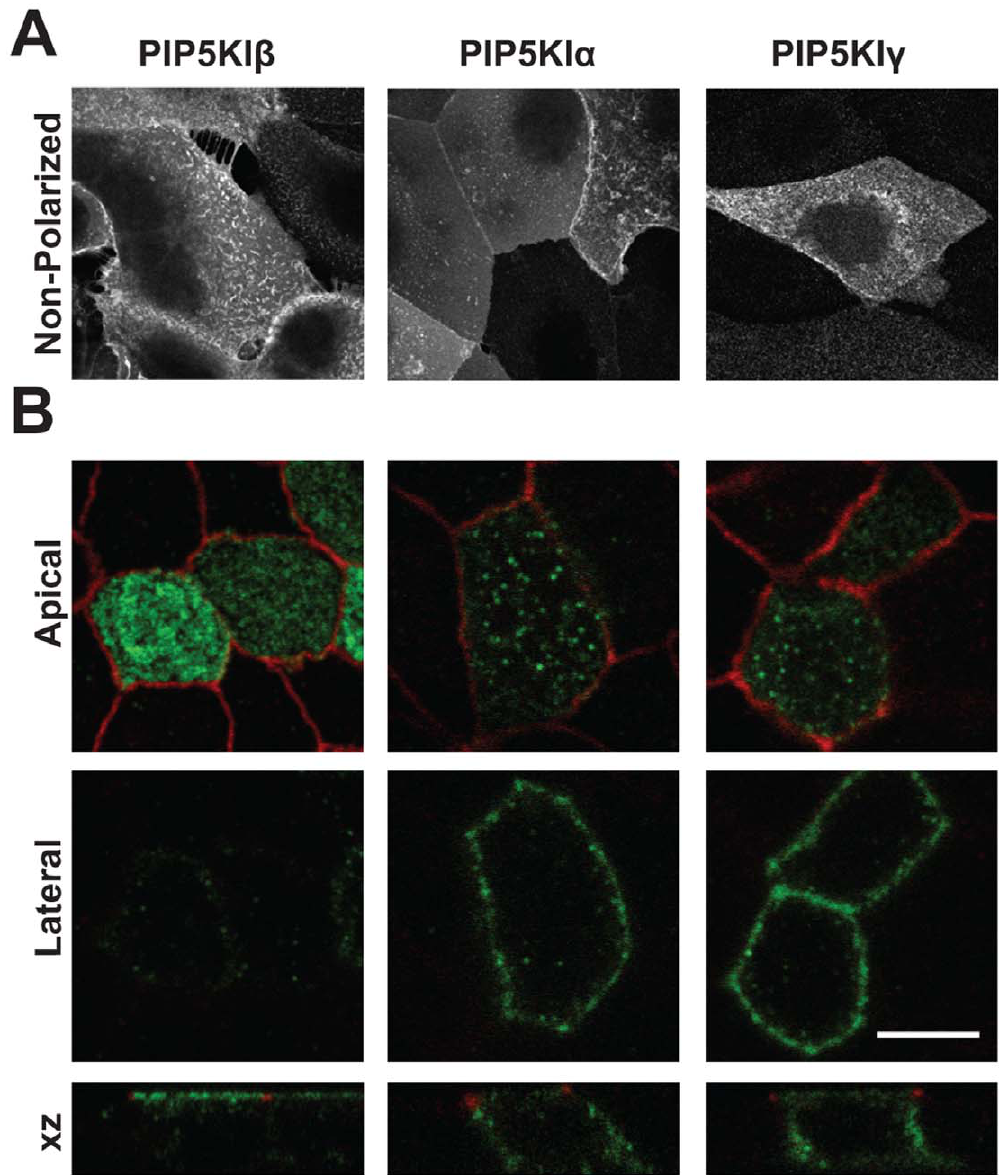
Figure 2. Localization of HA-tagged PIP5KI isoforms in polarized mCCD cells. Mouse cortical collecting duct cells grown on (A) coverslips (non-polarized) or on (B) permeable supports were infected with adenovirus encoding PIP5KI b , PIP5KI a or PIP5KI c and processed for indirect immunofluorescence to visualize PIP5KIs using anti-HA epitope antibody [green in (B)]. Anti-ZO-1 antibody was included in filter-grown cells (red) to mark tight junctions. All isoforms are localized to the plasma membrane as well as intracellular punctate structures in non-polarized cells. In contrast, PIP5KI isoforms are differentially distributed in polarized cells. Confocal sections acquired at the apical and lateral regions of cells are shown, as well as an xz reconstruction of the entire confocal stack. Whereas PIP5KI a and PIP5KI c are found in a non-polarized or lateral distribution, PIP5KI b localizes almost exclusively at the apical surface. Scale bar: 10 m m.